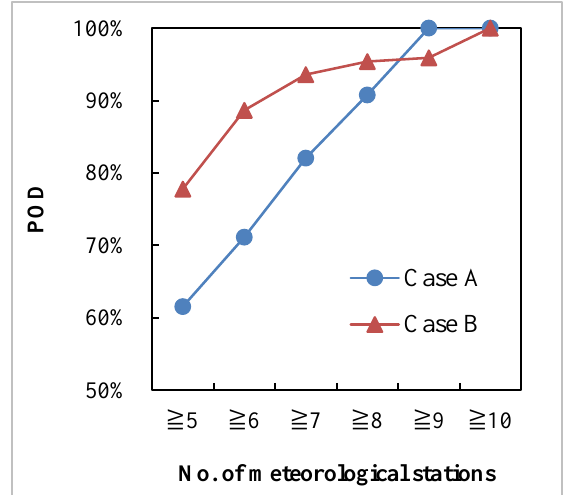
Figure 5. The relationships between probability of detection (POD) and station numbers for monitoring regional meteorological droughts with two different processing schemes.